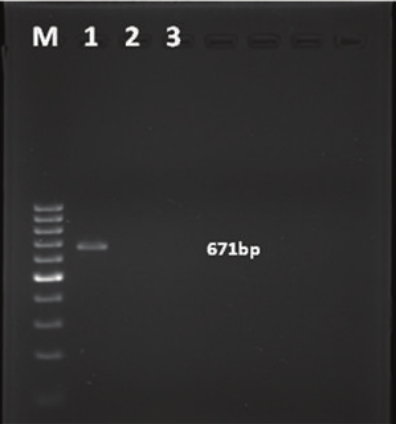
Figure 2: Babesia gibsoni species specific PCR assay. Lane M: GeneRuler 100 bp Ladder; lane 1: positive sample; lane 2: negative sample control; lane 3: negative DNA control.